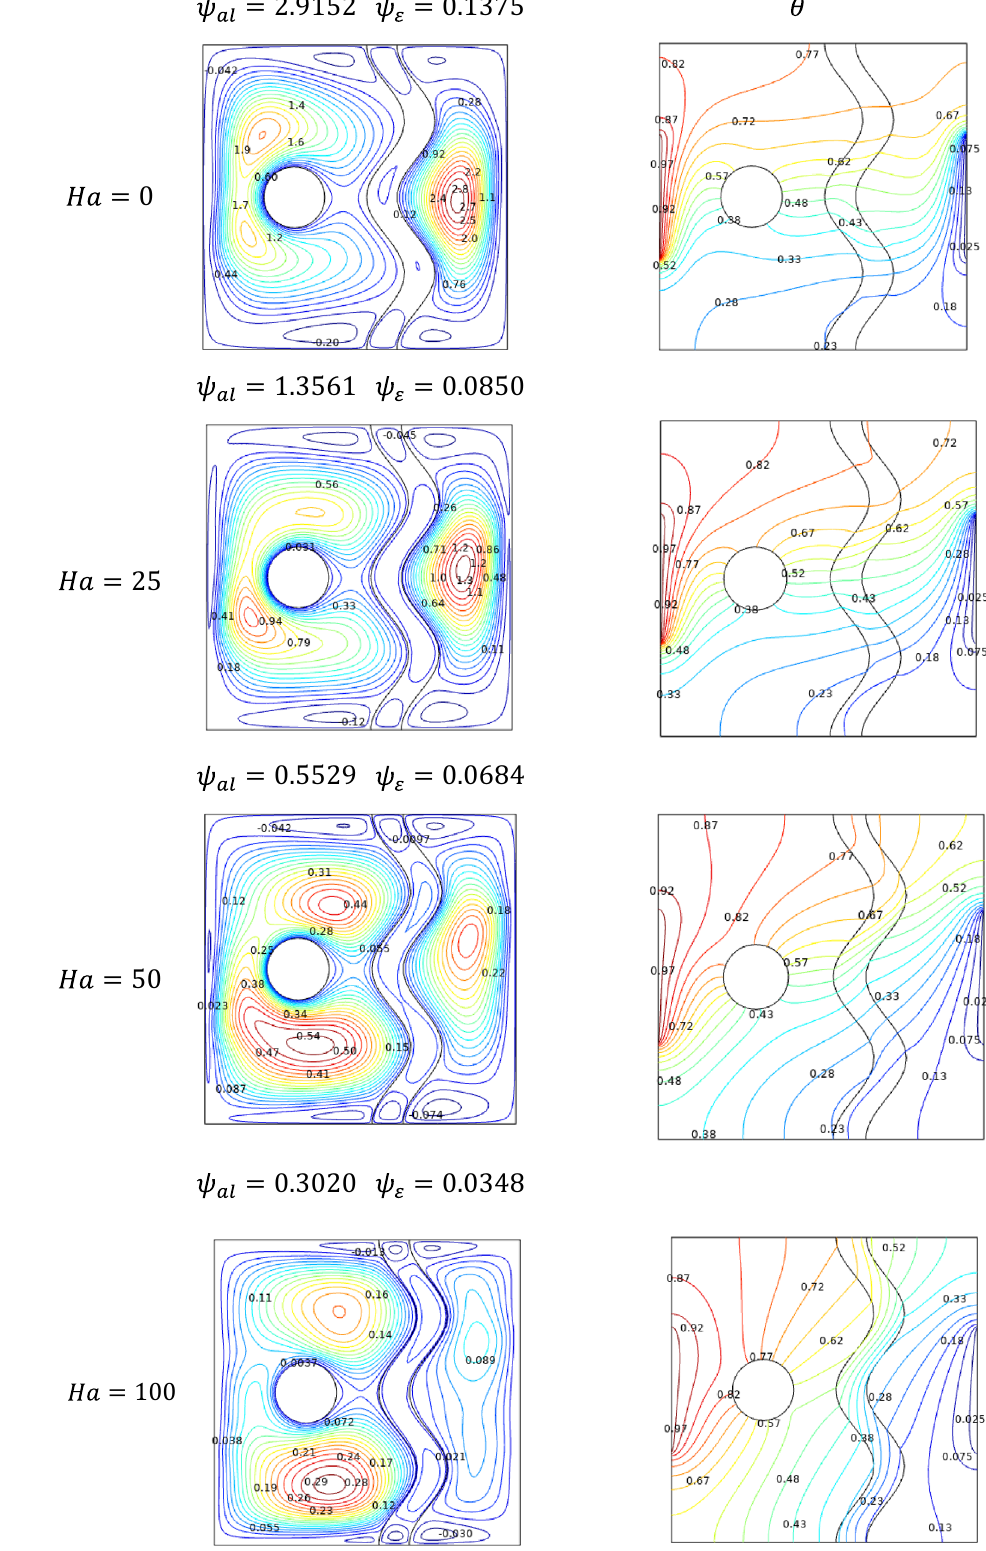
Figure 8. Variations of the streamlines (left), isotherms (right) with various Hartmann number ( Ha ) at 10 5 , Da 0.01 , N 0.2 and ω 0 0.02 , ε 2 , φ Ra = = = = = =